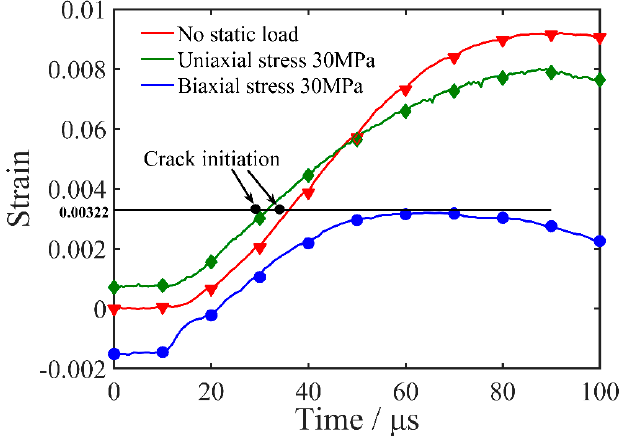
Figure 12. Variation of the maximum principal strain ε 1 at the blasthole center with time for different static loading conditions.